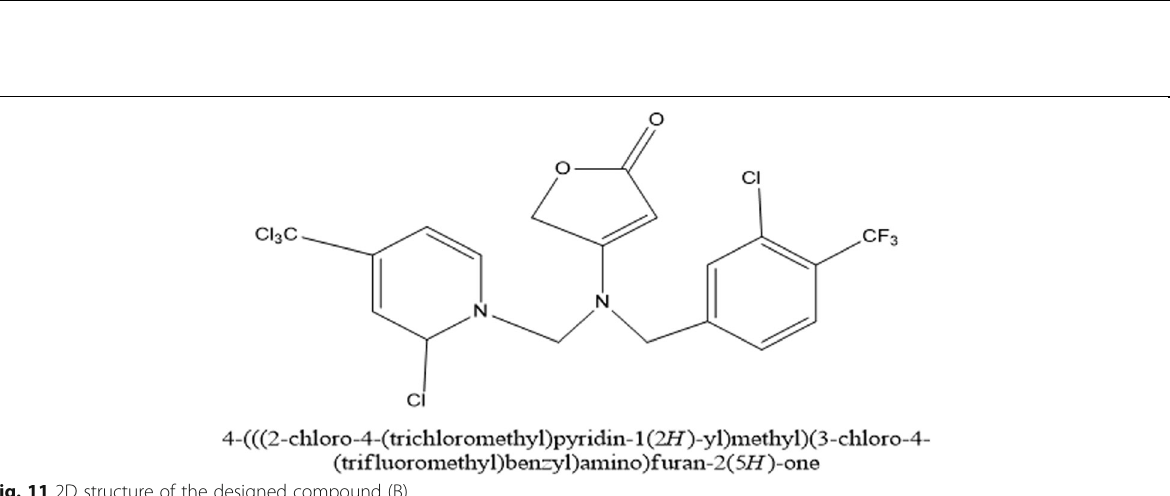
Fig. 10 2D structure of the designed compound (A)